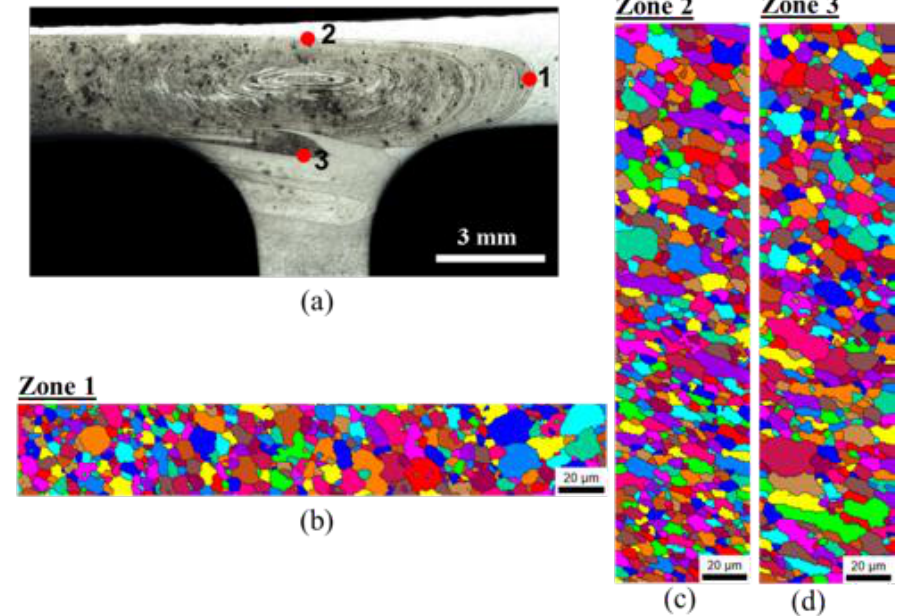
Figure 10. EBSD analysis conducted for the 265-30 weld: ( a ) zones analyzed and EBSD maps registered in zones 1 ( b ), 2 ( c ), and 3 ( d